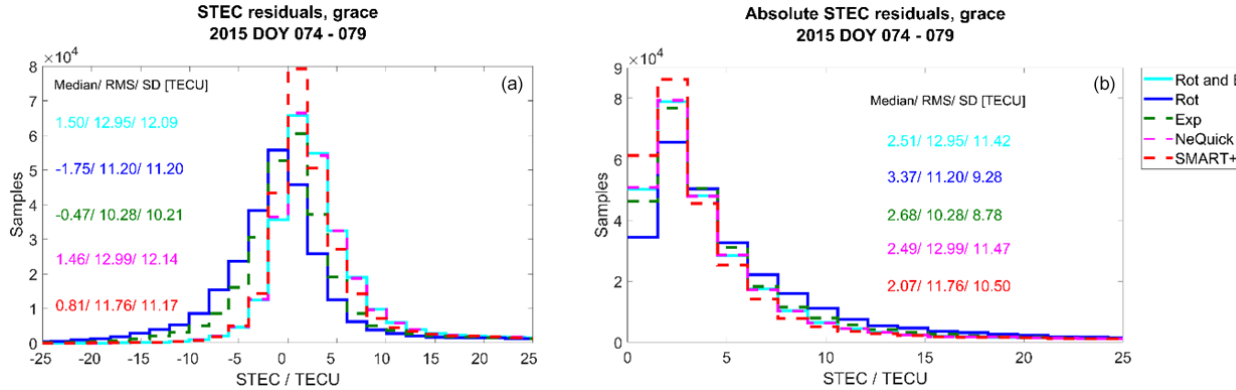
Figure 16. Histograms of the STEC residuals (a) and absolute residuals (b) during the perturbed period for